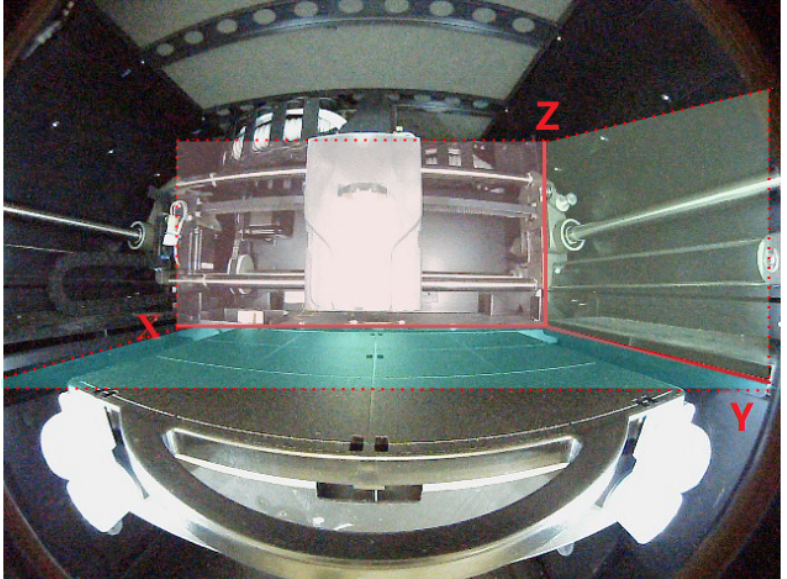
Figure 2. The canonical right-handed coordinate